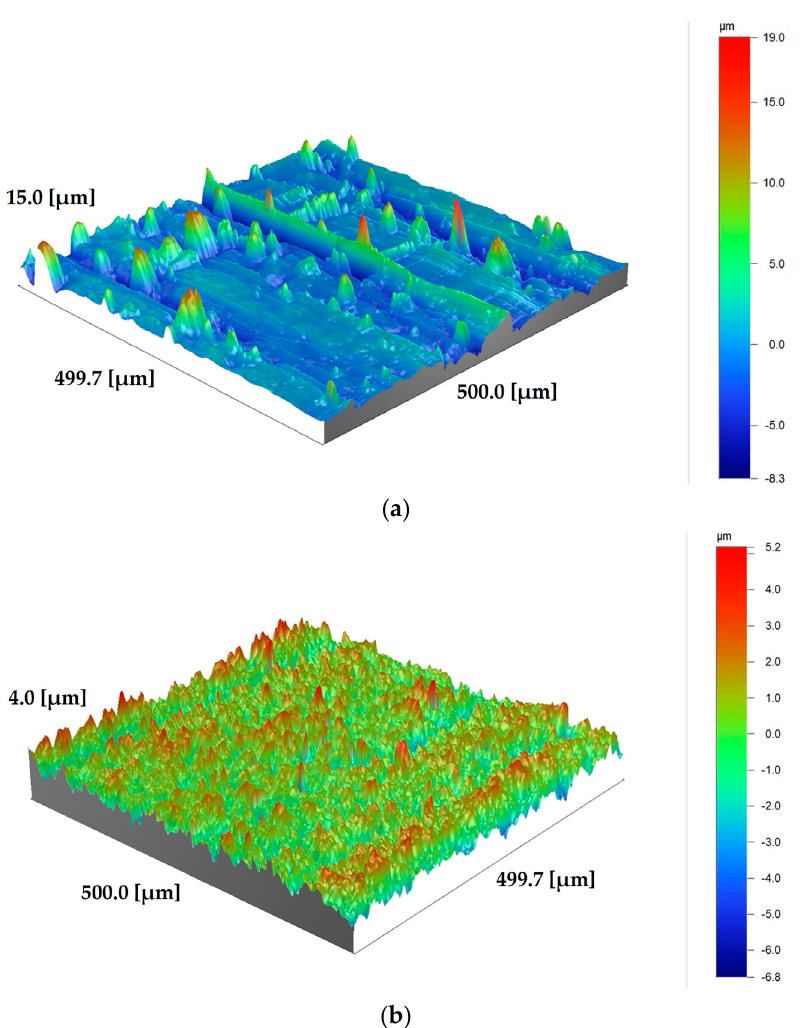
Figure 10. Surface topology of the samples (profilometry): ( a ) after production; ( b ) after vibration Figure 10. Surfacetopologyofthesamples(profilometry): ( a )afterproduction; ( b tumbling. Table 6. The roughness parameters ( R a , R z ) of the 12kH18N9T (AISI 321) steel surfaces before and after vibratory tumbling (before Gaussian regression).